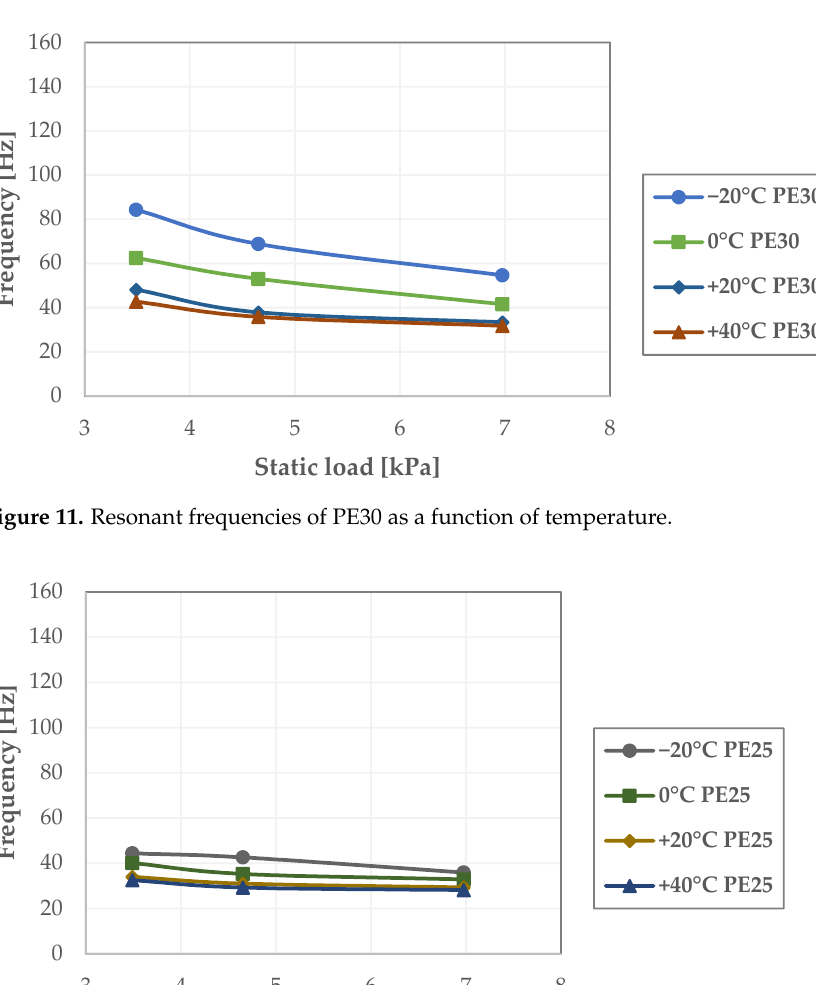
Figure 10. Resonant frequencies of XPE as a function of temperature.